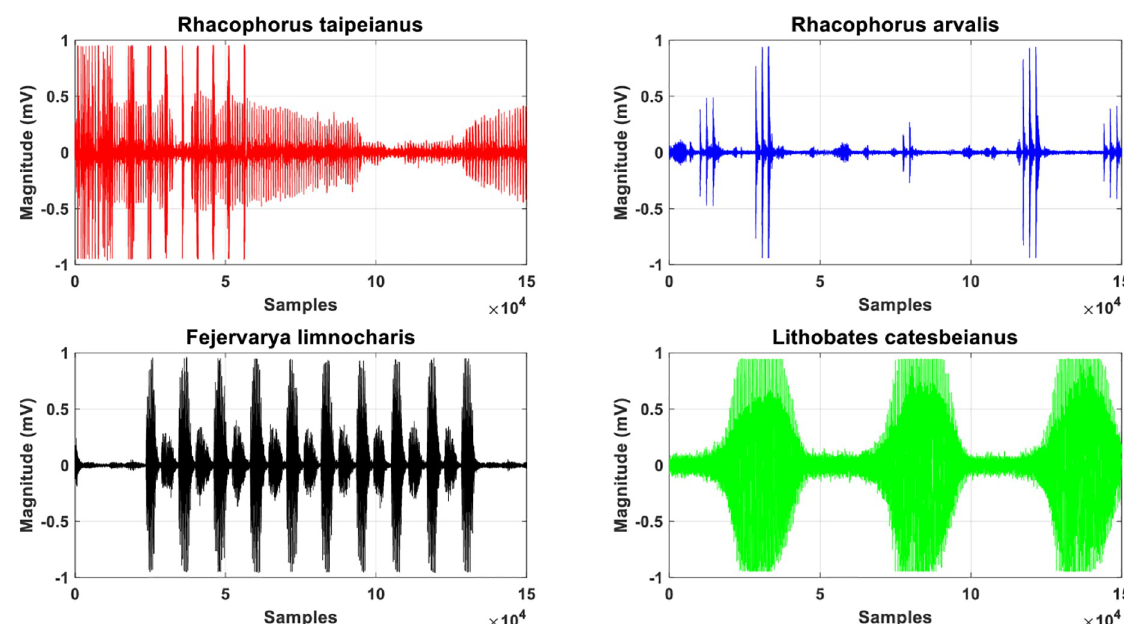
Fig 7. The collected data information of the first 4 anuras, including Rhacophorus taipeianus , Rhacophorus arvalis , Fejervarya limnocharis , Lithobates catesbeianus , is plotted with time length of approximately 20 seconds for each raw data.